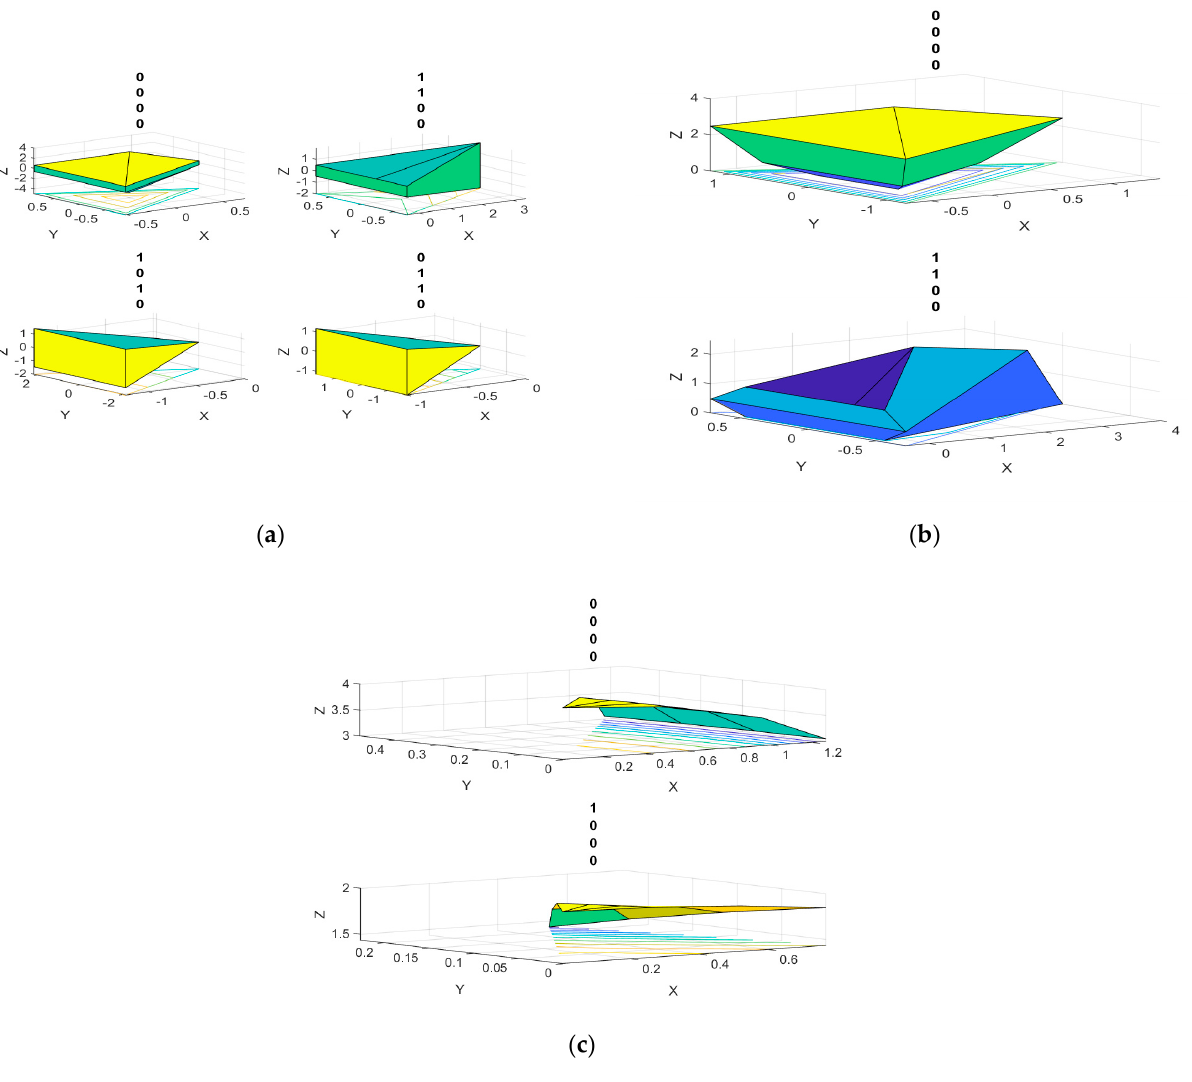
Figure 4. Optimal symbols for 𝜌 = 4 and 𝛾 = 1.3 for the considered space ( a ) 0 ≤ 𝜃 ≤ 𝜋 & 0 ≤ 𝜙 ≤ 2𝜋, ( b ) 0 ≤ 𝜃 ≤ 𝜋/2 & 0 ≤ 𝜙 ≤ 2𝜋 , and ( c ) 0 ≤ 𝜃 ≤ 𝜋/8 & 0 ≤ 𝜙 ≤ 𝜋/8 .